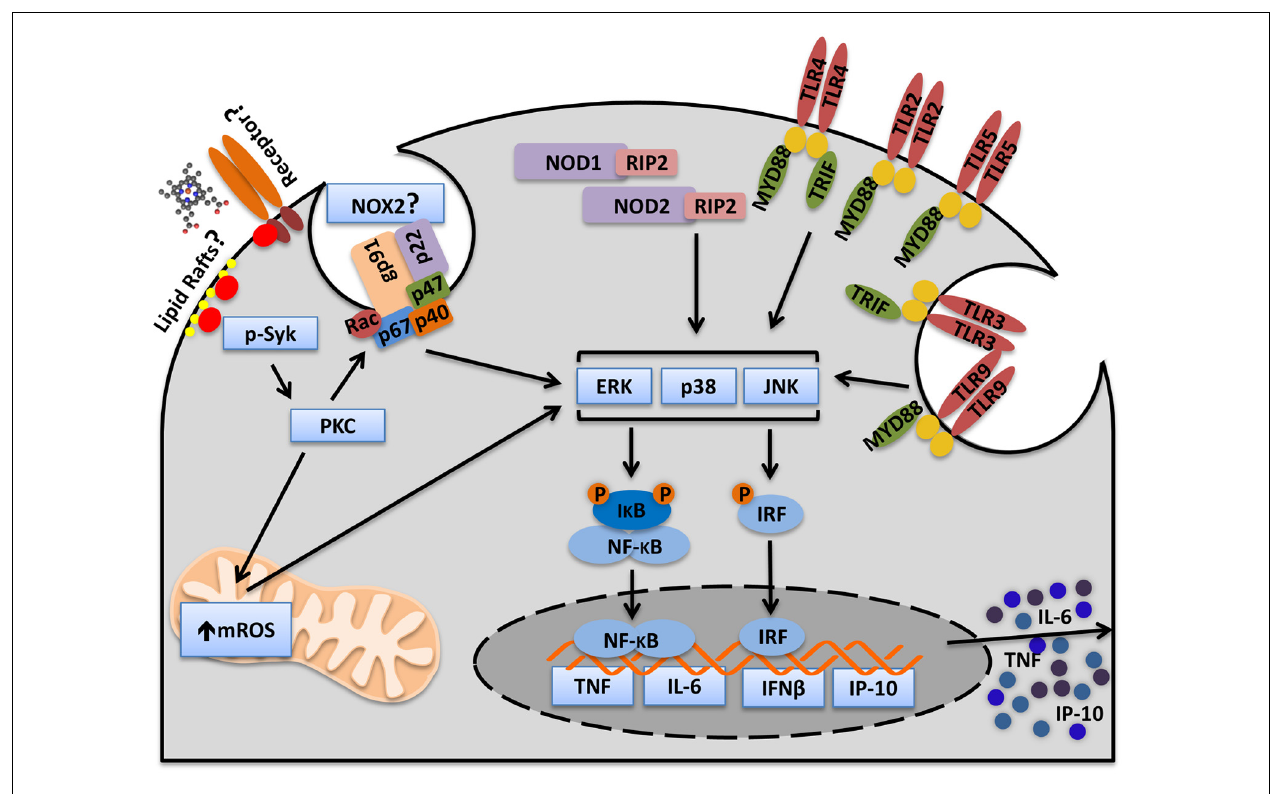
FIGURE 3 | Heme activates Syk and amplifies cytokine production induced by PAMPs. Heme induces Syk phosphorylation in macrophages.The Syk pathway is essential for heme-induced ROS production. Heme-induced ROS generation increases MAPKs and NF κ B activation and consequently, cytokine production. Heme amplifies cytokines induced by cell surface receptors (TLR2,TLR4,TLR5), endosome receptors (TLR3,TLR9), and cytosolic receptors (NOD1 and NOD2). Moreover, heme amplifies MyD88- (TNF and IL-6) andTRIF-dependent (IP-10) cytokines.The mechanism by which